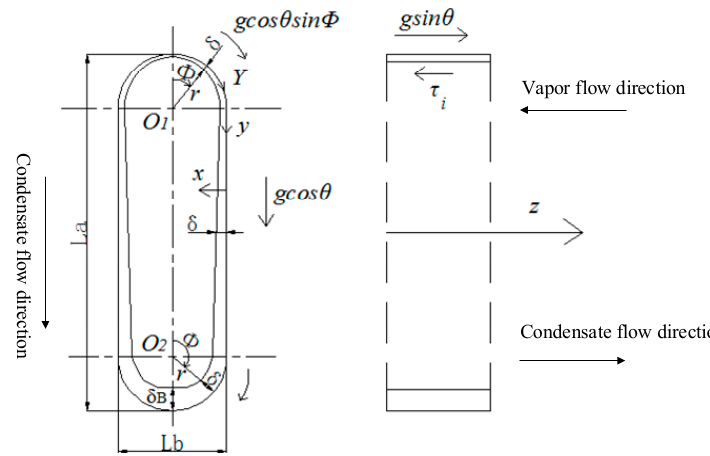
Figure 3. The equivalent model for steam-side condensation of finned flat tube.